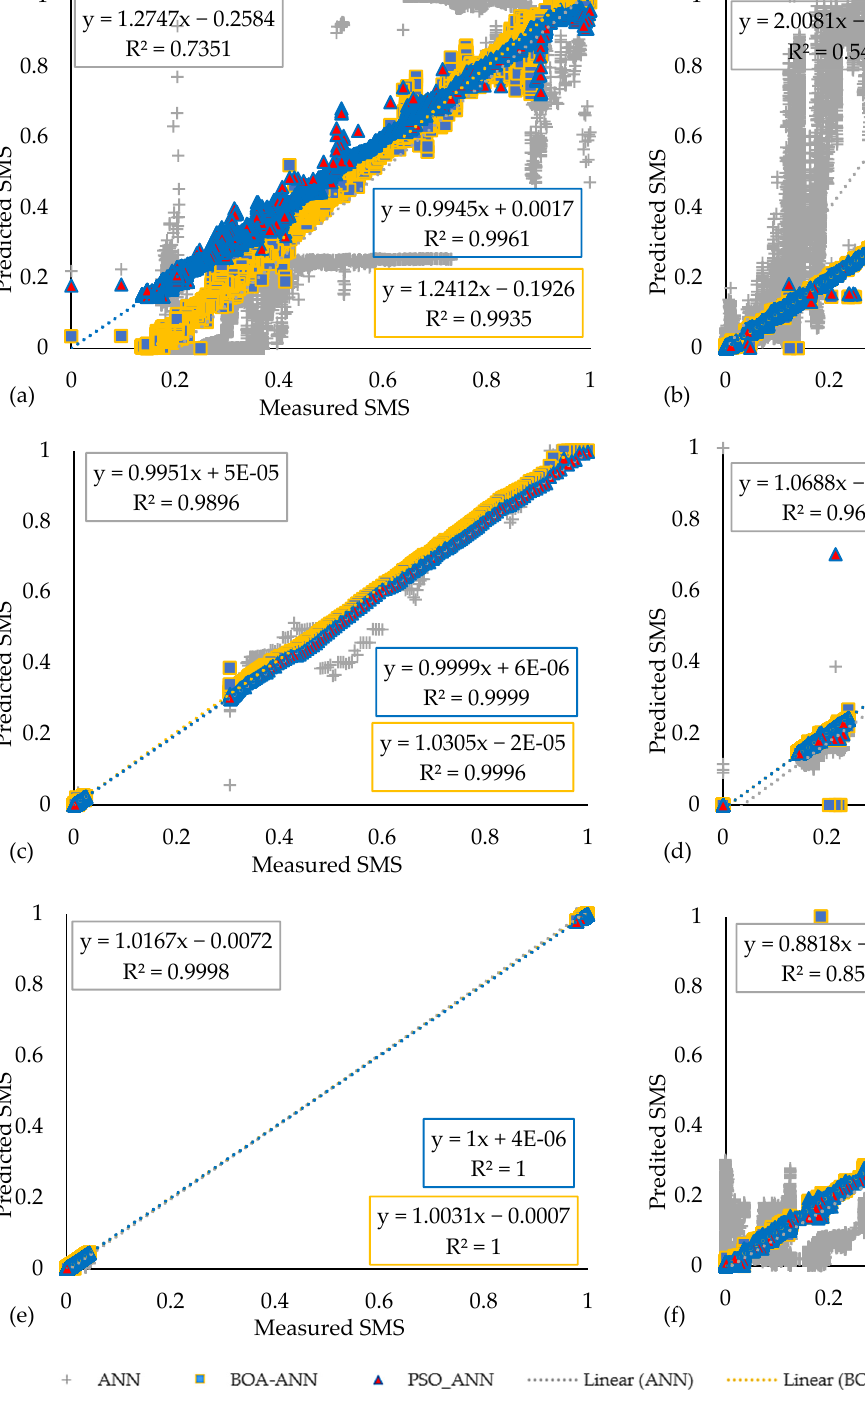
Figure A4. Predicted vs. measured SMS at 4.5 m depth overtime via ANN-BR, PSO-ANN, and BOA-ANN ( a ) HWS 1 ( b ) HWS 2 ( c ) HWS 3 ( d ) HWS 4 ( e ) HWS 5 ( f ) HWS 6.